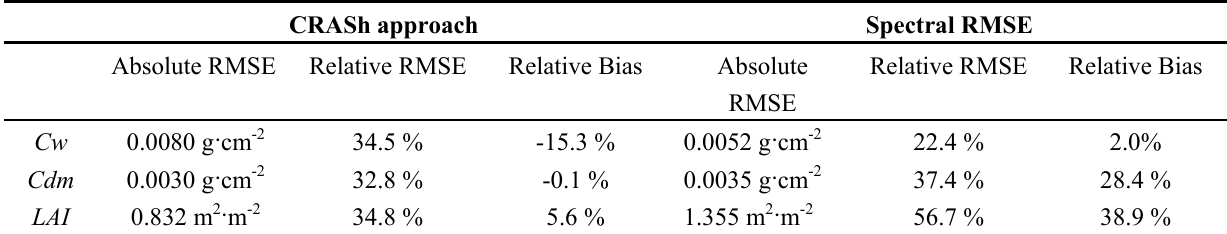
Table 6. Absolute and relative RMSE between in situ measurements of Cw , Cdm and LAI and estimates obtained from field spectrometer measurements using the CRASh approach.